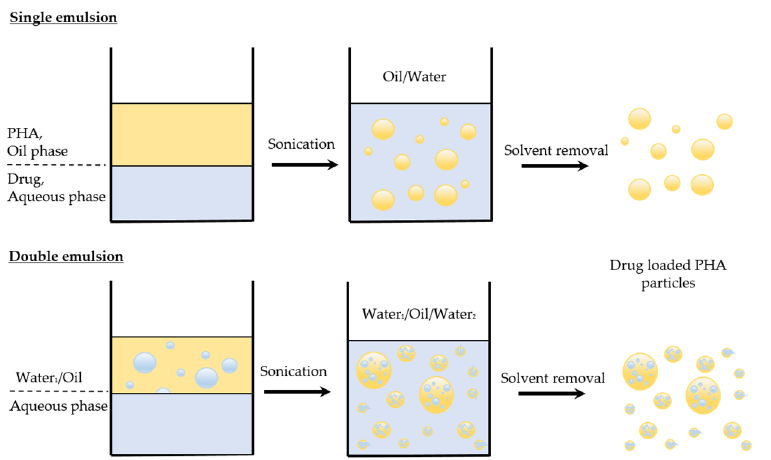
Figure 2. The emulsion solvent evaporation method to produce PHA nanoparticles. The drug is either dissolved in the oil phase with the PHA (oil/water, single emulsion) or emulsified in the oil phase (water 1 /oil/water 2 , double emulsion) and then further emulsified in the continuous water phase. This is followed by solvent evaporation and washing with distilled